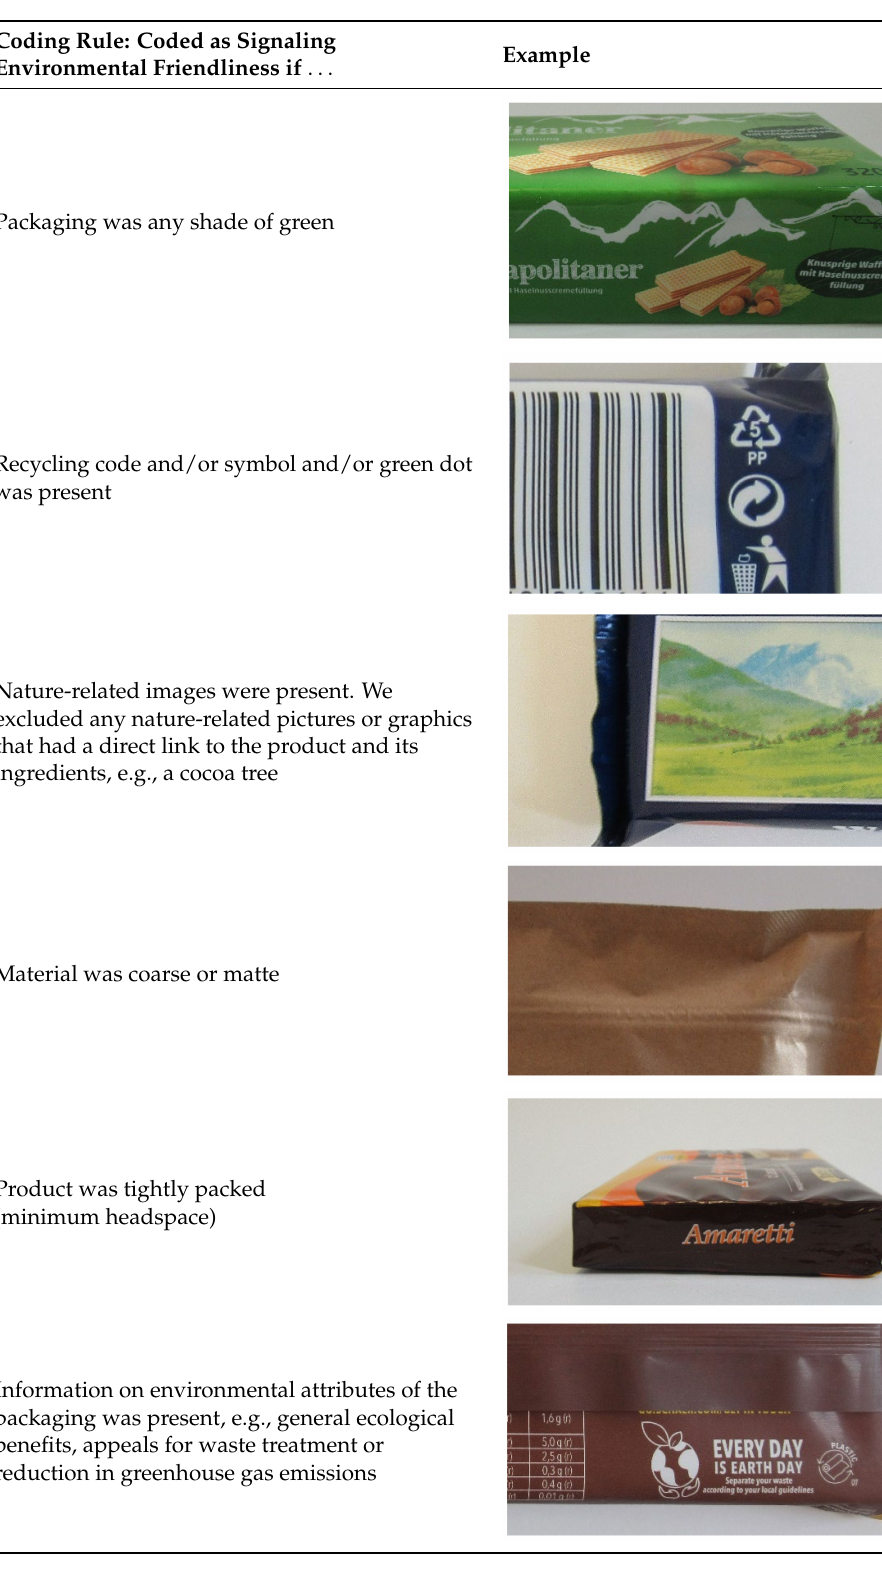
Table A1. Examples of coding rules for the